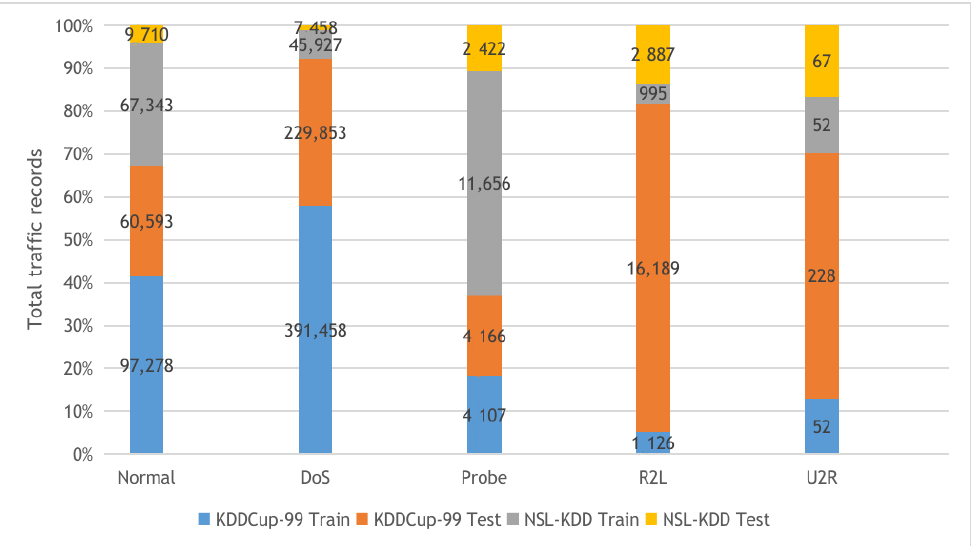
Figure 4. The KDDCup-99 and NSL-KDD datasets training and testing sets